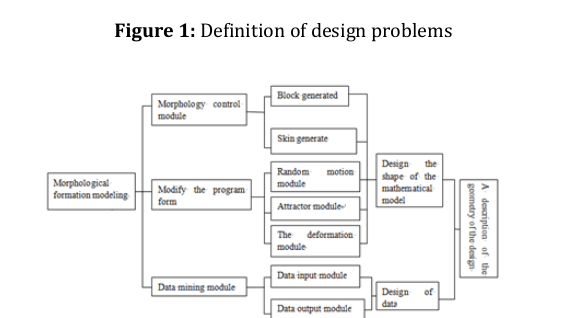
Figure 2: The parameters of the scheme